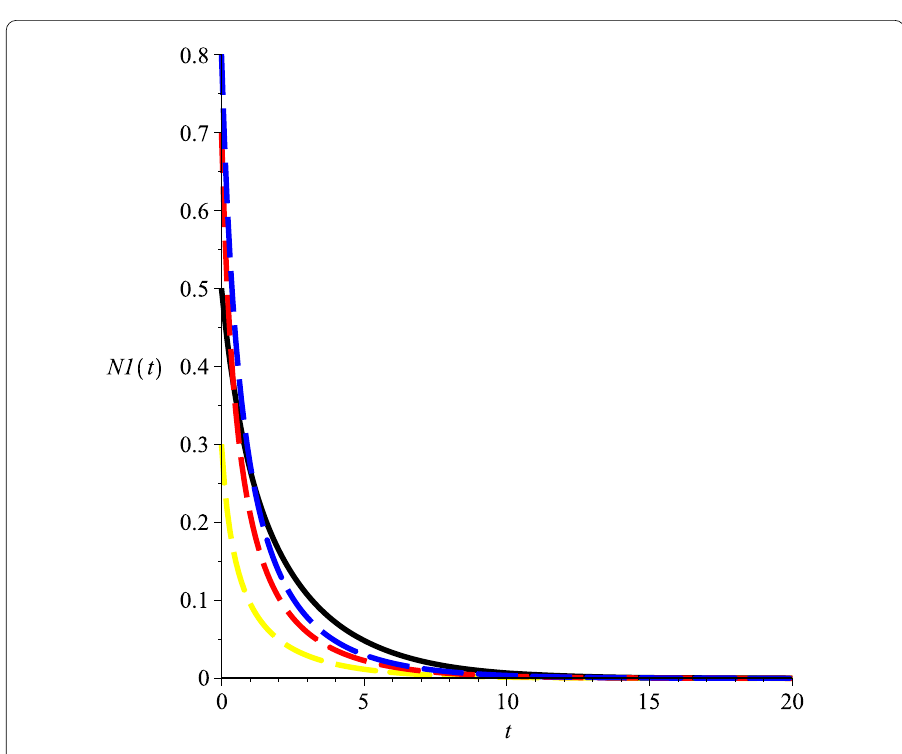
Figure 5 Numeric simulations of the first components of system (5.1) with m = 0.3, the initial conditions ( x (0), y (0)) = (0.5,0.1),(0.8,1),(0.3,3), and (0.7,2),